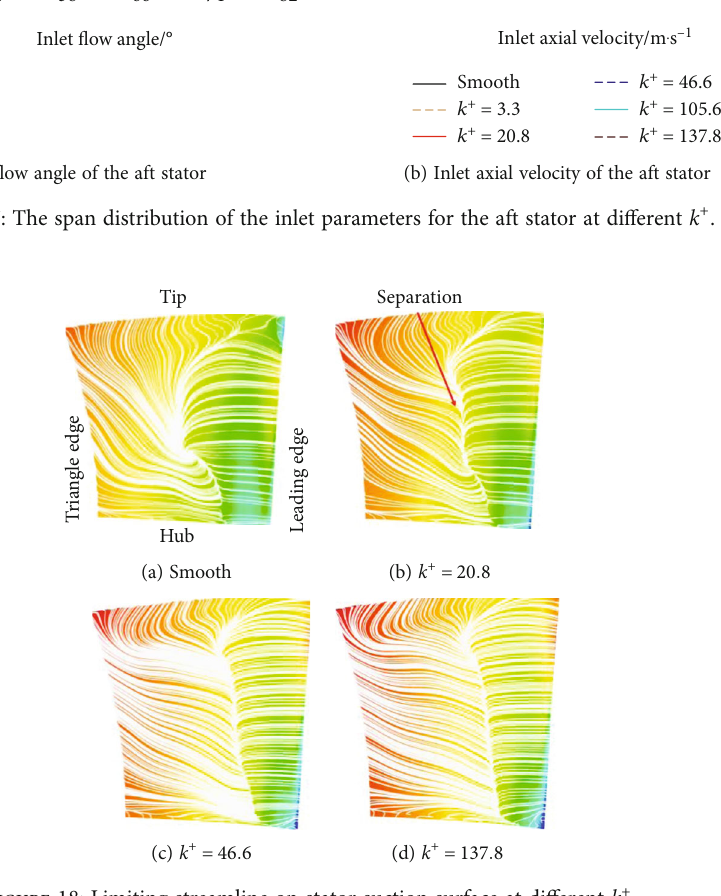
Figure 18: Limiting streamline on stator suction surface at di ff erent k +